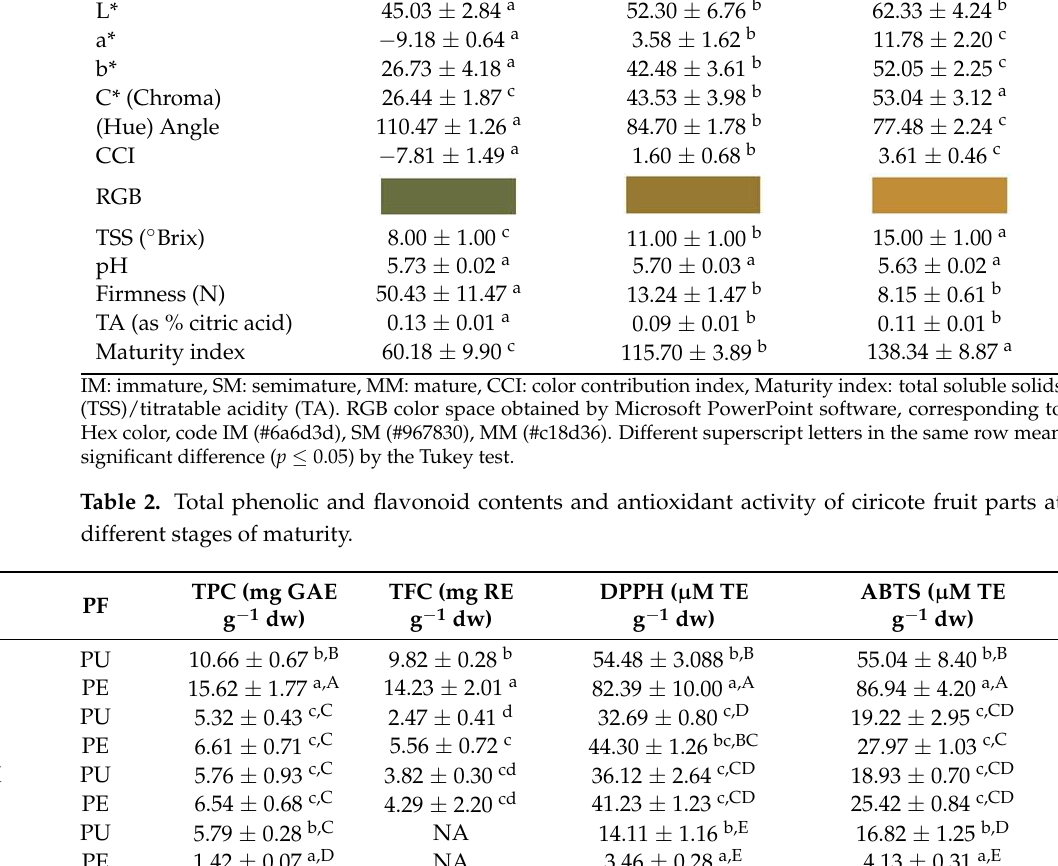
Table 2. Total phenolic and flavonoid contents and antioxidant activity of ciricote fruit parts at dif- ferent stages of maturity.